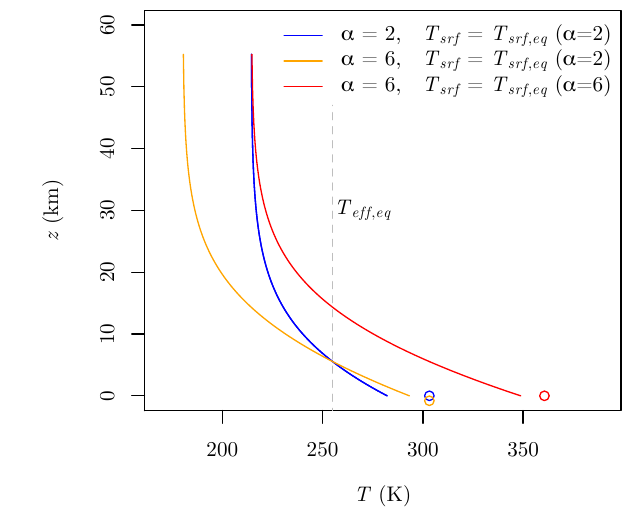
Figure 5. Vertical temperature profiles of a grey atmosphere for two equilibrium states and one transient state. While the blue and red curves show the same equilibria as the corresponding curves in Fig. 2, the orange curve shows the transient state that occurs after switching from α = 2 to α = 6, directly after equilibration of the atmosphere but with T srf still unchanged. Again α corresponds to α o in the window-grey model with β w = 0. T eff = 255K. The circles at z = 0 denote the corresponding surface temperatures. Note that the vertical coordinate z is only approximate height, calculated from h with a constant scale height H = 8km such that h = 1 − e − z/H